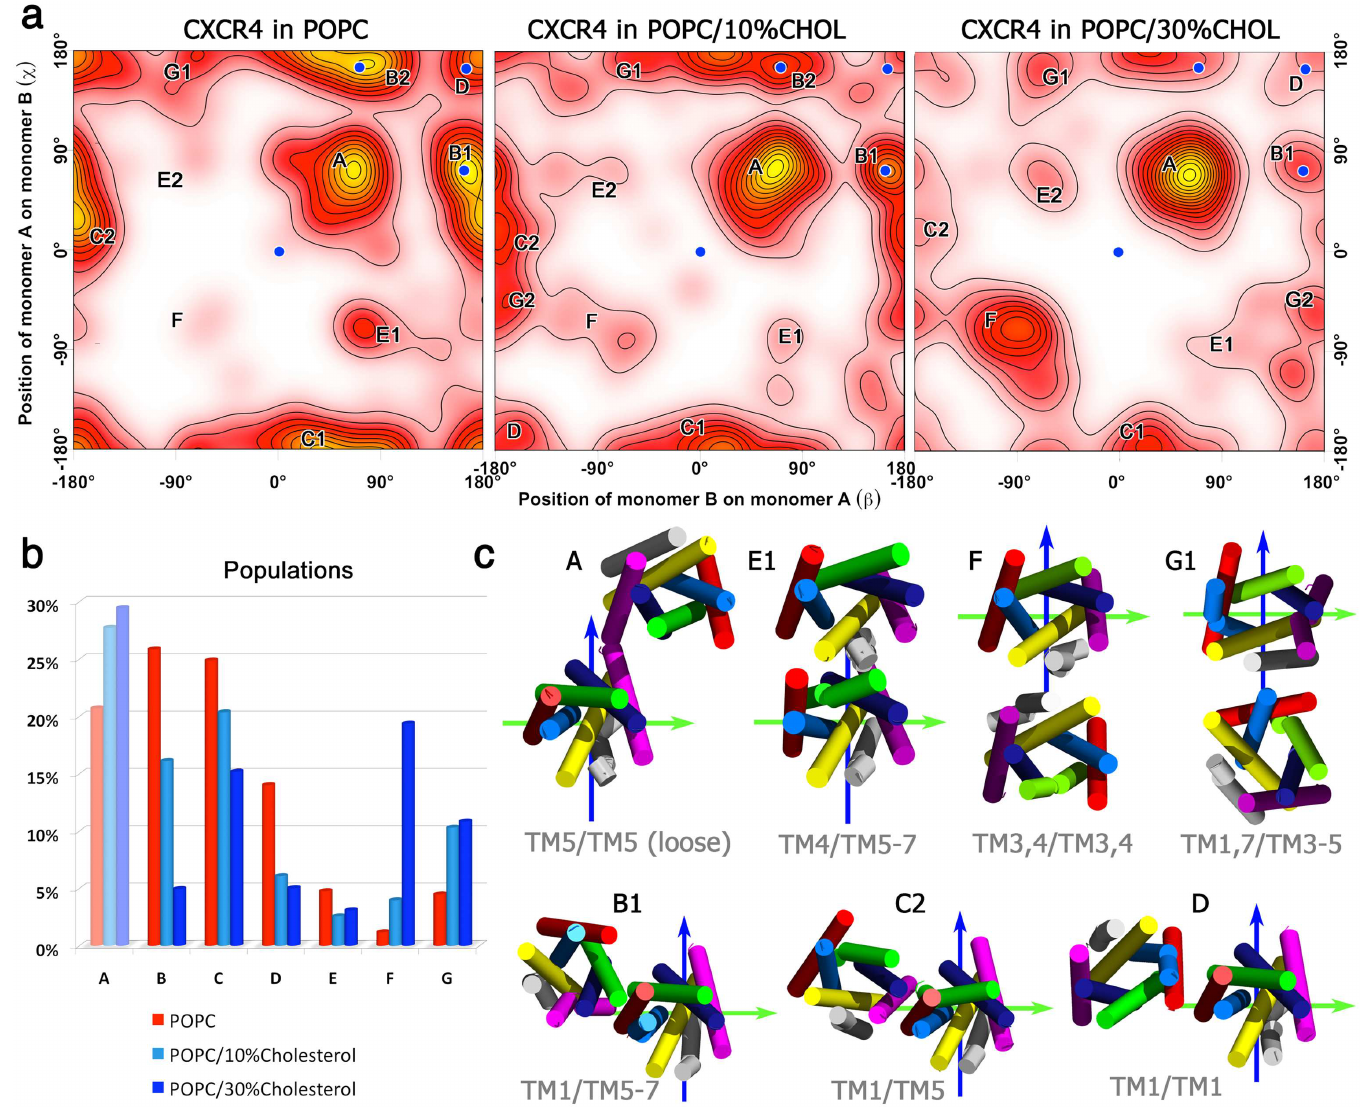
Fig 2. Spontaneously assembled CXCR4 dimers. ( a ) Sampled CXCR4 dimer configurations in pure POPC bilayers after 3 μ s (left), and in mixed POPC: cholesterol bilayers after 6 μ s simulation time at 10% (middle) and 30% cholesterol content (right). The β and χ angles are defined relative to the crystal TM5,6/TM5,6 interface (central blue dots, see Methods Section for the exact definitionof the angles β and χ ). ( b ) Relative populationsfor the dimer configurations definedin (a) and (c). ( c ) Representative dimer configurations corresponding to labeledmaxima A to G in (a) are shown in cylindric representation and colored equallyas in Fig 1. Symmetric structures ( C1 and C2 corresponding to TM1/TM5 and TM5/TM1, respectively) are distinguished by indices 1 and 2. The reference structure for all dimer configurations is indicatedby green and blue axes.